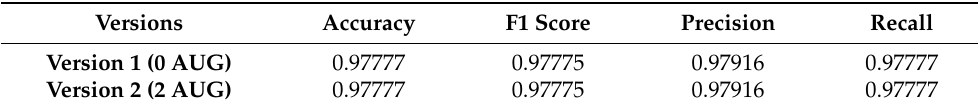
Table 16. Metrics of the RF classification algorithm obtained with the first model. Each column refers to a different metric, as defined in Section 2.4.2. Each row refers to a different version of the model.